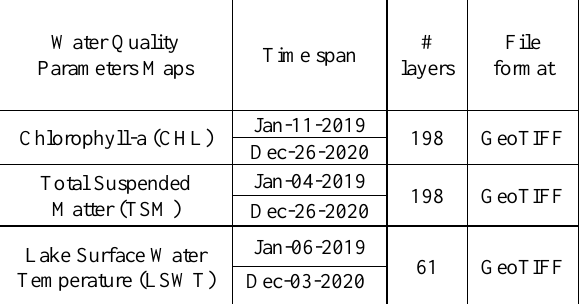
Table 1. Datasets currently ingested into the platform